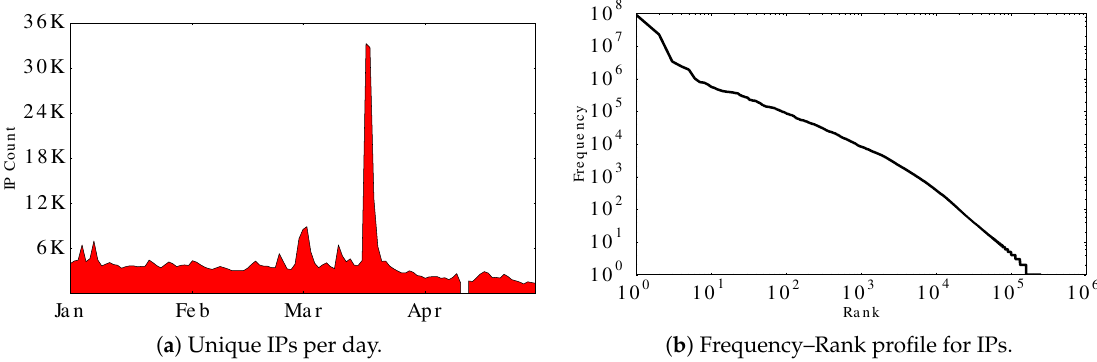
Figure 4. Statistical information for IP addresses